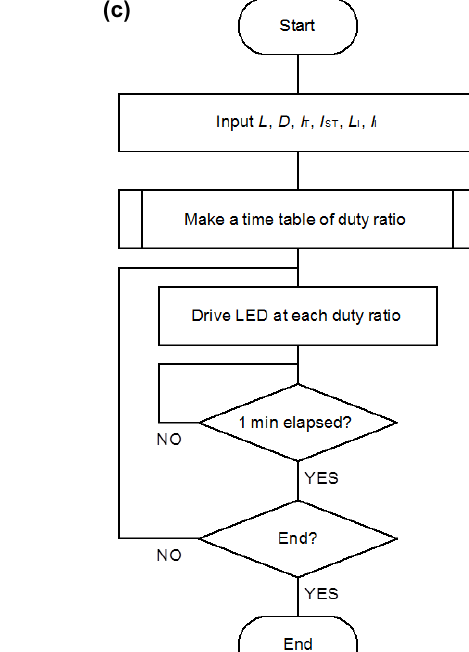
, night-interrupting light period; I , T ST ; L , duty ratio during L ; I , duty ratio T I I